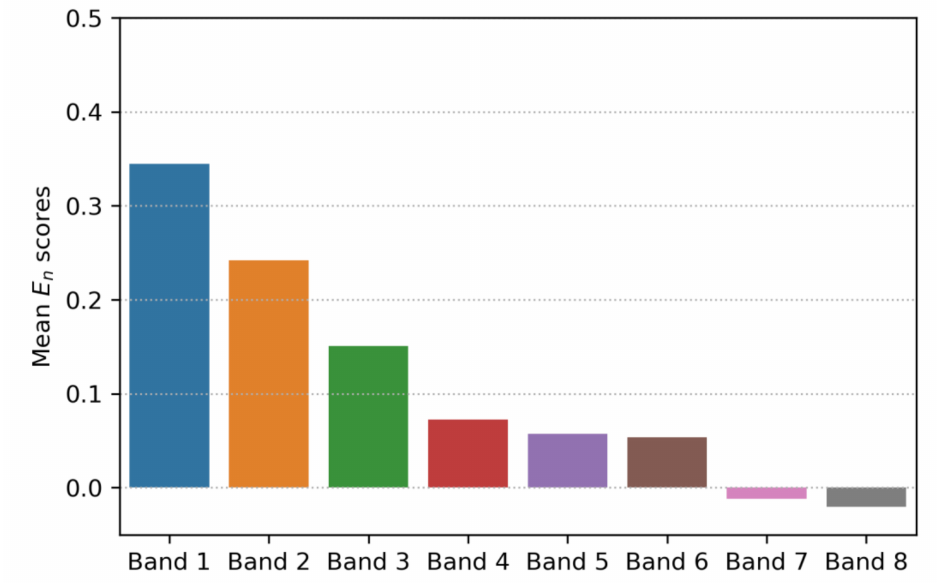
Figure 8. Mean E n scores for GOCI channels. Total, 4855 pairs were used in this analysis.